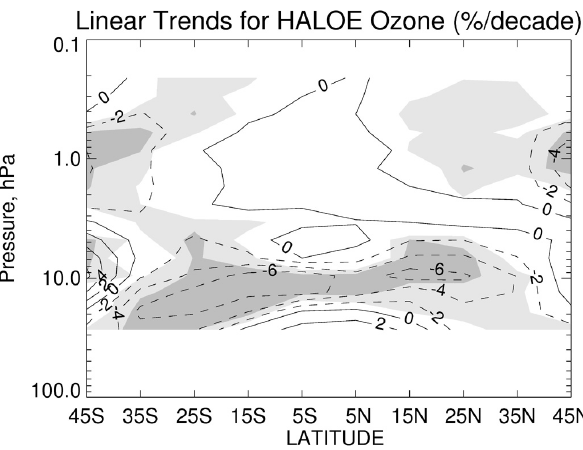
Fig. 14. As in Fig. 8, but for the linear trend terms from the HALOE ozone. Regions of darker shading denote CI > 90%; regions of lighter shading have 70% < CI <